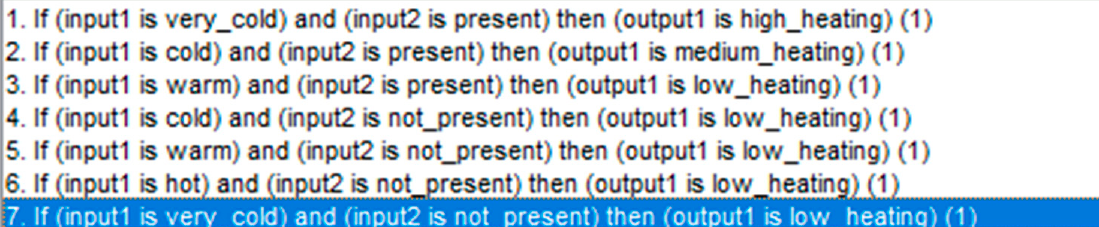
Figure 8. Verbal control rules for heating.